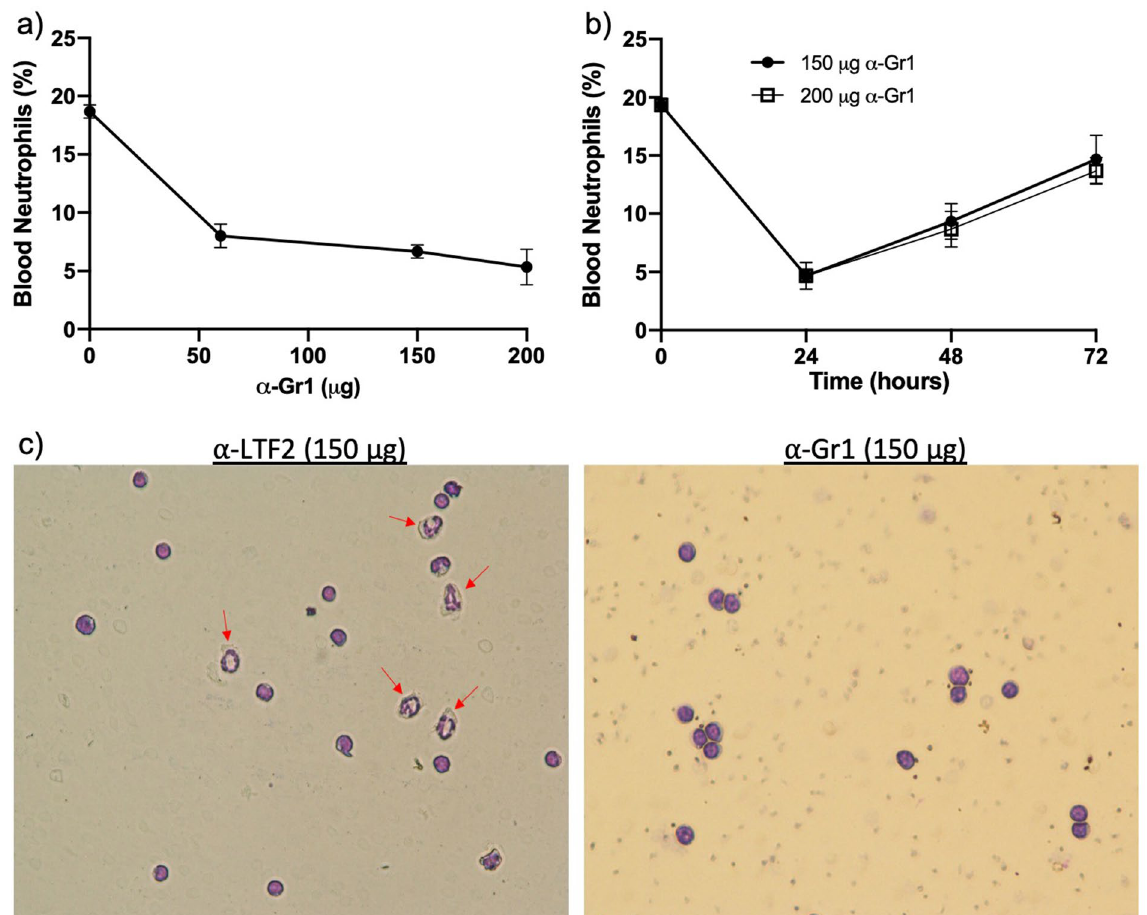
Figure 1. Peripheral blood neutrophil depletion: animals were treated intraperitoneally with different doses of α-Gr1 (0–200 μg). After 24 h, blood was collected by tail snip, and neutrophil depletion was analyzed under conventional microscopy ( a , c ). Neutrophil depletion was observed up to 72 h after a single dose of α-Gr1 ( b ). Data from three independent experiments (n = 2 animals per experiment) were compiled together. Red arrows show neutrophils—× 40 magnification ( c